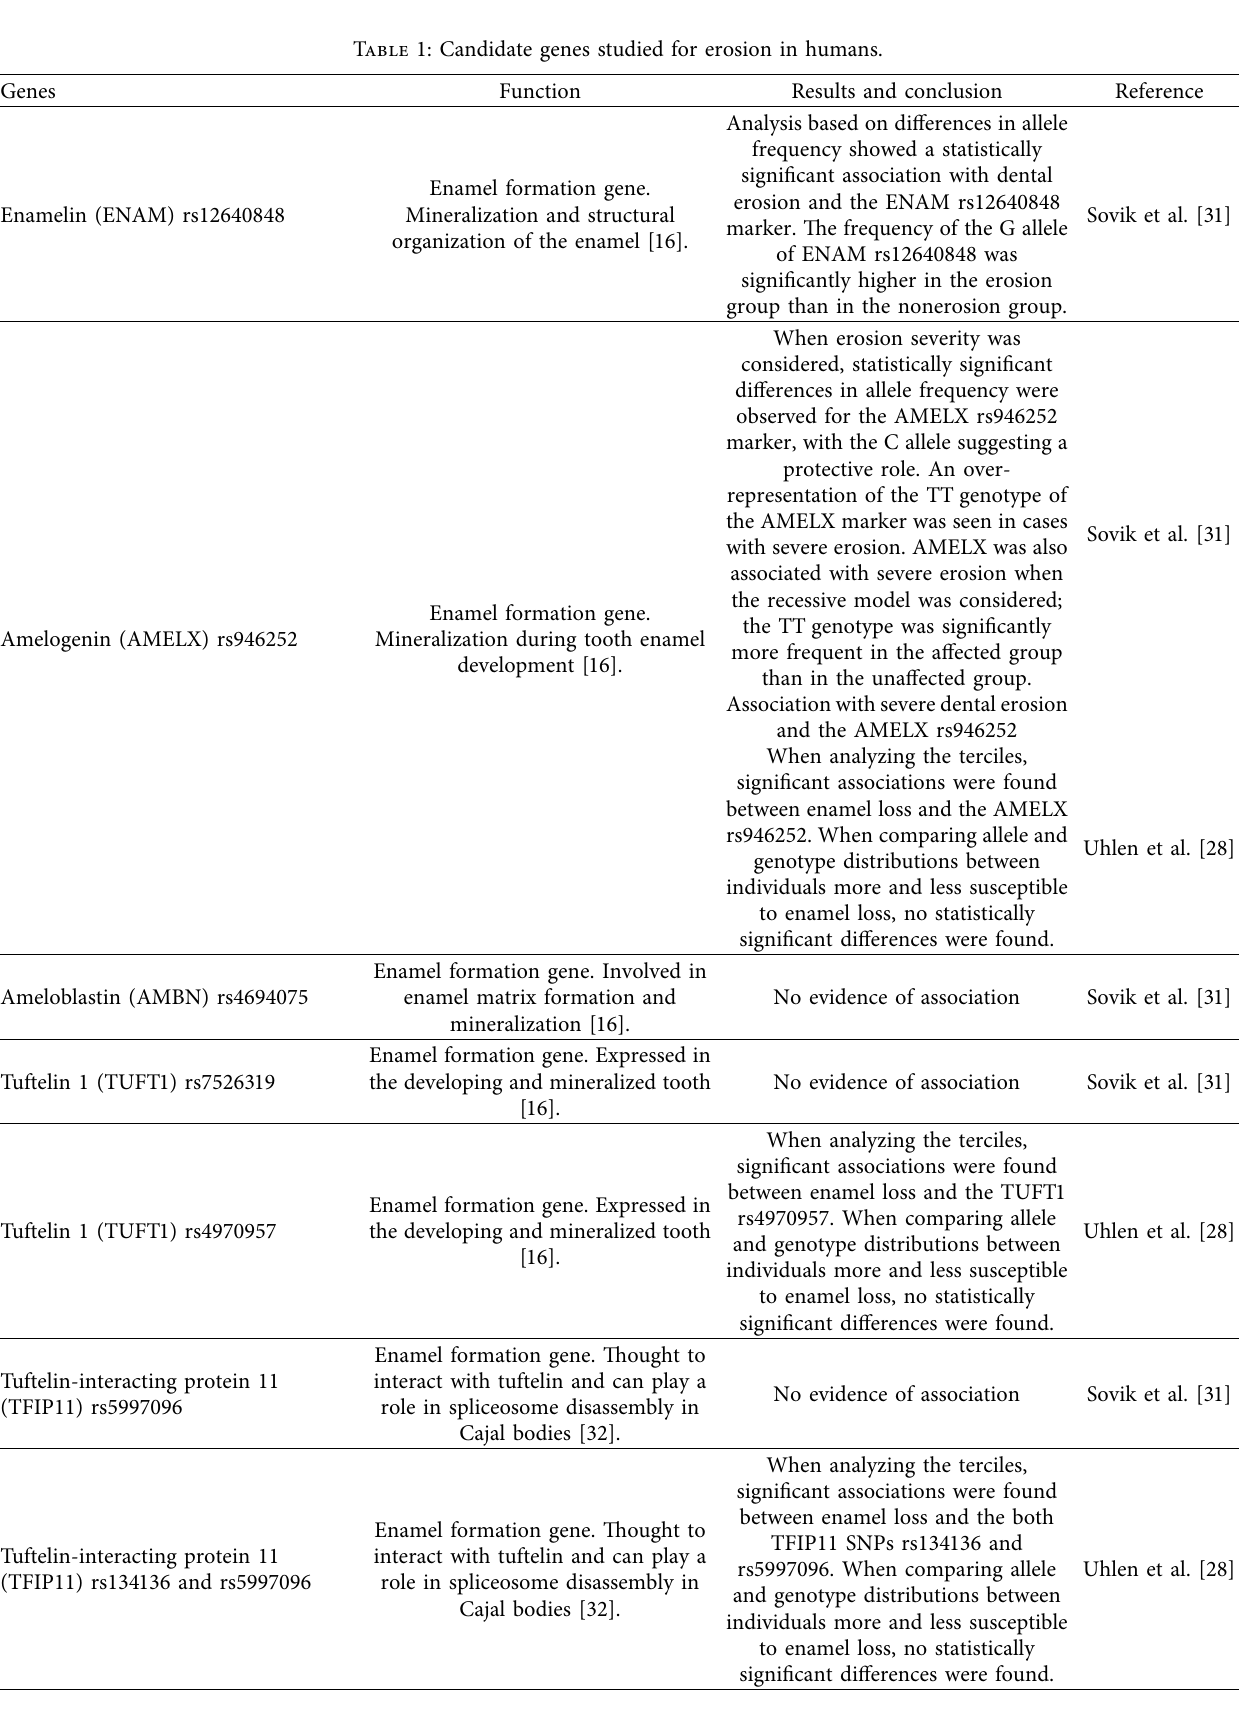
Table 1: Candidate genes studied for erosion in